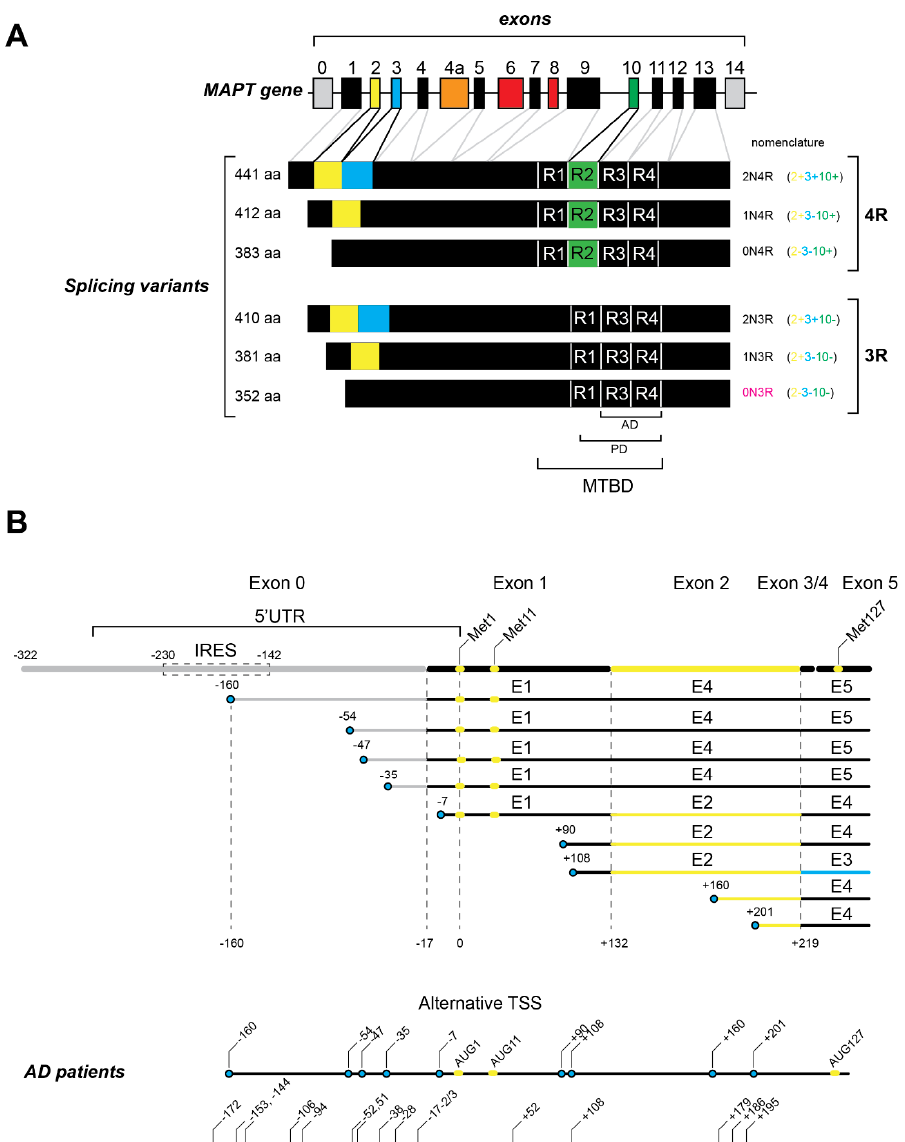
Figure 1. Tau mRNA transcripts. ( A ) Tau mRNA transcripts are generated from the single MAPT gene and consist of 16 exons (numbered 0 to 14). The coding sequence starts in exon 1. In the adult human brain, six splicing variants are generated by alternative splicing of exon 2 (light green), exon 3 (blue) and exon 10 (green). All of these variants contain three (3R) or four (4R) microtubule binding repeats (R). Exon 4a (orange) is only transcribed in peripheral nervous system. Exons 6 and 8 (red) are not transcribed in human brain. The microtubule binding repeats constitute the microtubule -binding domain (MTBD). The regions of Tau filaments that have been observed by cryo-EM in Alzheimer’s disease patients (G273/305 to E380) and Pick’s disease patients (K254 to F378 in 3R Tau) are indicated as (AD) and (PD), respectively. ( B ) The 5 (cid:48) ends of tau mRNA transcripts in Alzheimer’s disease patients determined by 5 (cid:48) RACE experiments (Huin et al., 2017). The position of the IRES in the 5 (cid:48) UTR is boxed by a dashed line. The positions of methionine codons 1, 11 and 127 are shown in light green. The positions of the 5 (cid:48) ends are represented by blue circles. The numbers of nucleotides upstream of the AUG start are indicated by numbers prefixed with the minus sign ( − ). The numbers of nucleotides downstream of the AUG start are indicated by numbers prefixed with the positive sign (+). The deduced alternative transcription start sites (TSS) found in AD patients are summarized in the bottom of the panel and compared with the TSS found in a normal brain (light green